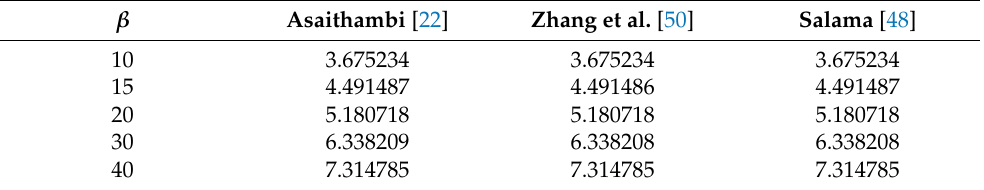
Table 3. Falkner–Skan solutions ( f (cid:48)(cid:48) ( 0 )) for select values of β ∈ [ 10,40 ] . β Asaithambi [22] Zhang et al.